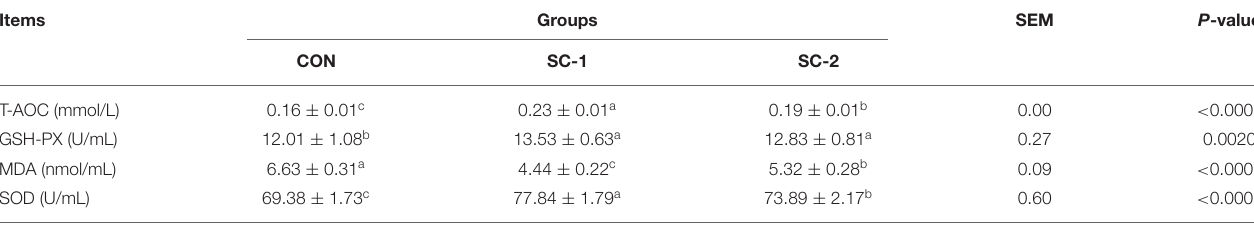
TABLE 7 | Effect of different Saccharomyces cerevisiae cultures on serum antioxidant indices in dairy cows. Items Groups SEM